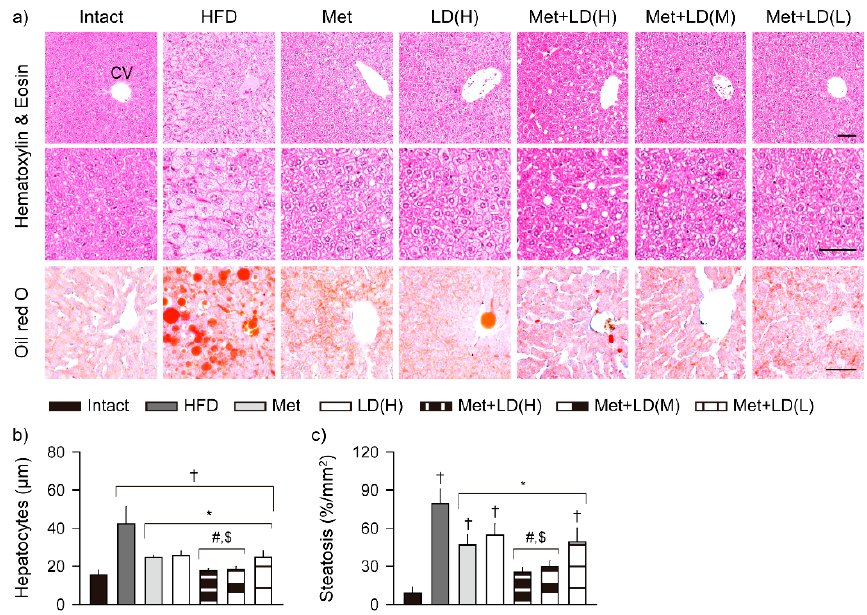
Figure 7. Histopathological improvements in lesions of the liver. ( a ) Representative images in stains with hematoxylin and eosin and oil red O. CV = central vein. Scale bars = 50 μ m. ( b , c ) Sizes of the hepatocytes and steatosis areas stained with oil red O. Values are represented as the means ± SDs ( n = 8). †, *, #, and $: p < 0.05 vs. the Intact, HFD control (HFD), Met, and LD(H) groups, respectively.